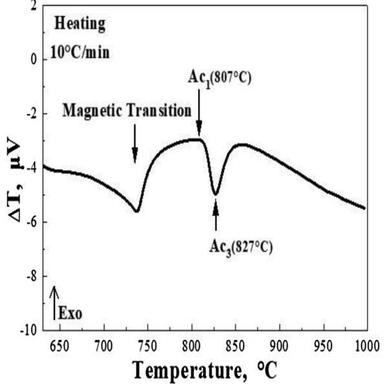
DTA profile of the novel carbide-free 9Cr-ODS steel. The transformation temperatures of Curie point, Ac1 and Ac3 are indicated by arrows.